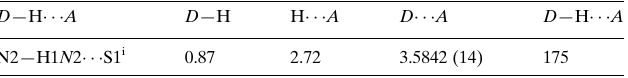
Hydrogen-bond geometry (A˚ , (cid:2)